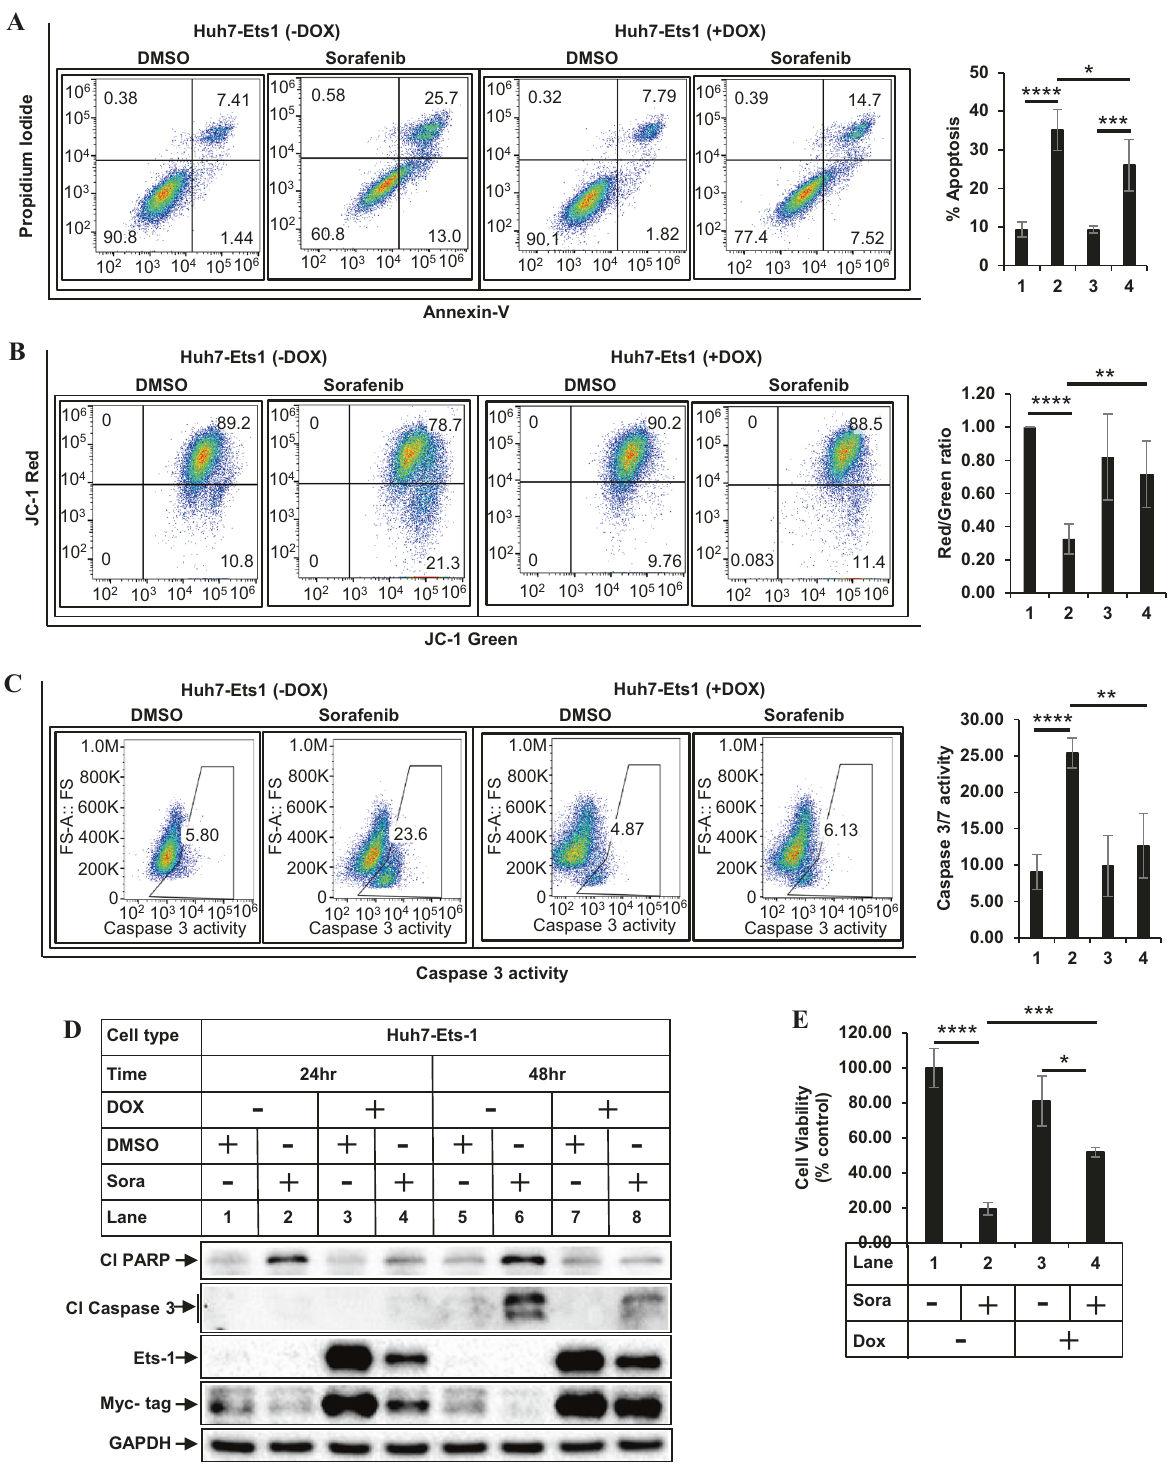
Fig. 5 Overexpression of Ets-1 promotes sorafenib resistance. Huh7-Ets-1 WT stable cells were treated with ( + ) or without ( − ) DOX for 24 hours to induce ectopic Ets-1 expression, followed by treatment with DMSO or sorafenib (6 µM) for 48 h and fl ow cytometry to detect apoptosis ( A ), mitochondrial damage ( B ), or caspase 3/7 activity ( C ). The bar graphs on the right of A – C represent the degree of apoptosis, mitochondrial damage, and caspase 3/7 activity respectively. Lanes 1 and 2 were treated without DOX and lanes 3 and 4 were treated with DOX, along with DMSO (lanes 1, 3) or sorafenib (lanes 2, 4). The data represent the mean ± S.D. of at least 4 – 6 independent experiments. D Huh7-Ets-1 WT stable cells treated with ( + ) or without ( − ) DOX for 24 h followed by treatment with DMSO or sorafenib (6 µM) for an additional 24 and 48 h were analyzed by western blots. Cl PARP cleaved PARP, Cl Caspase 3 cleaved caspase 3. E Huh7-Ets-1 WT cells pretreated with DOX followed by treatment with DMSO ( − ) or 6 µM sorafenib ( + ) for 72 h were analyzed by MTT assay. The data represent the mean ± S.D. of three independent assays. Signi fi cant differences were determined by t test and indicated as: * p ≤ 0.05; ** p ≤ 0.01; *** p ≤ 0.001; **** p ≤ 0.0001. Cell Death and Disease (2022)